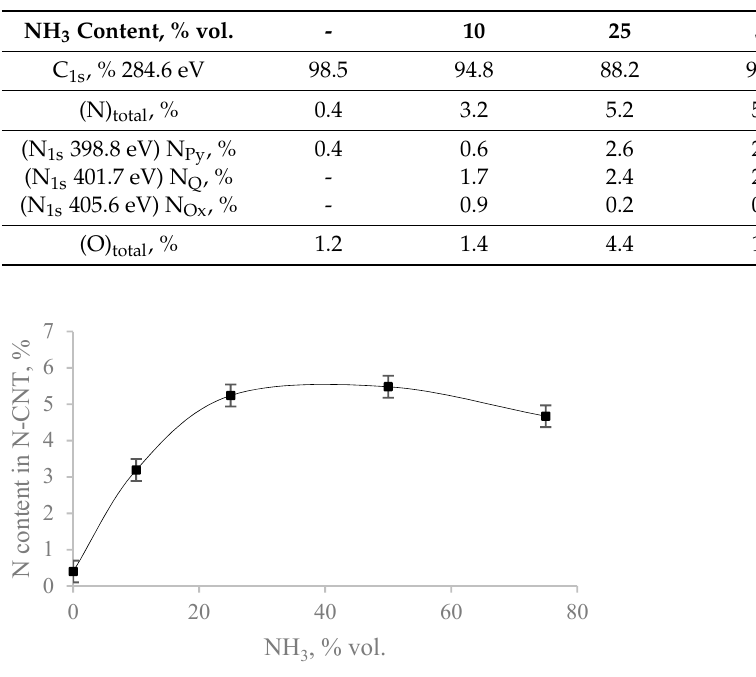
Figure 3. Dependence of N total content in samples on NH 3 content in the mixture.